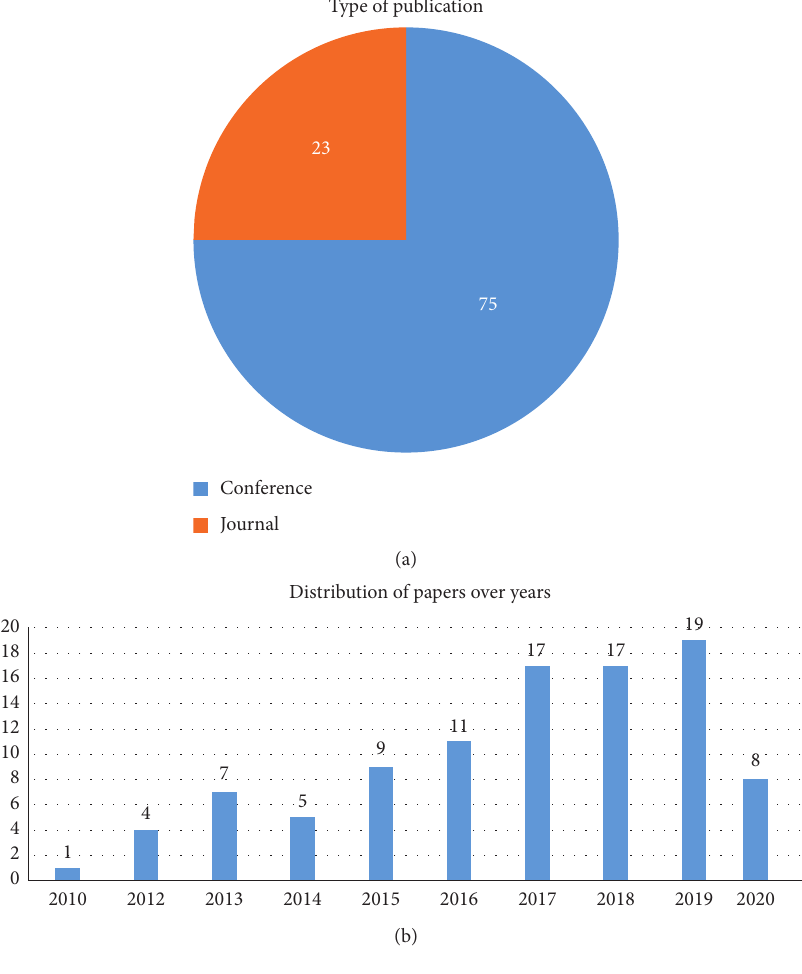
Figure 4: (a) Publication venues and (b) distribution of papers over the